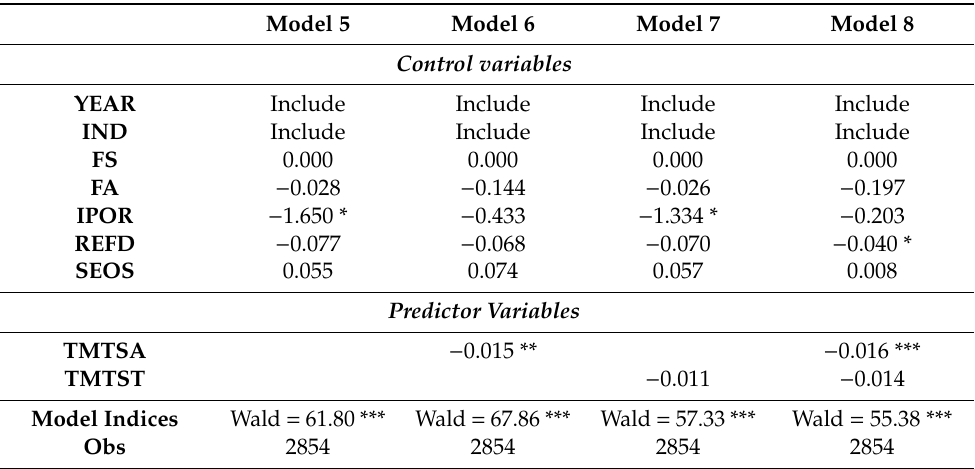
Table 5. Results of regression analyses on M&A